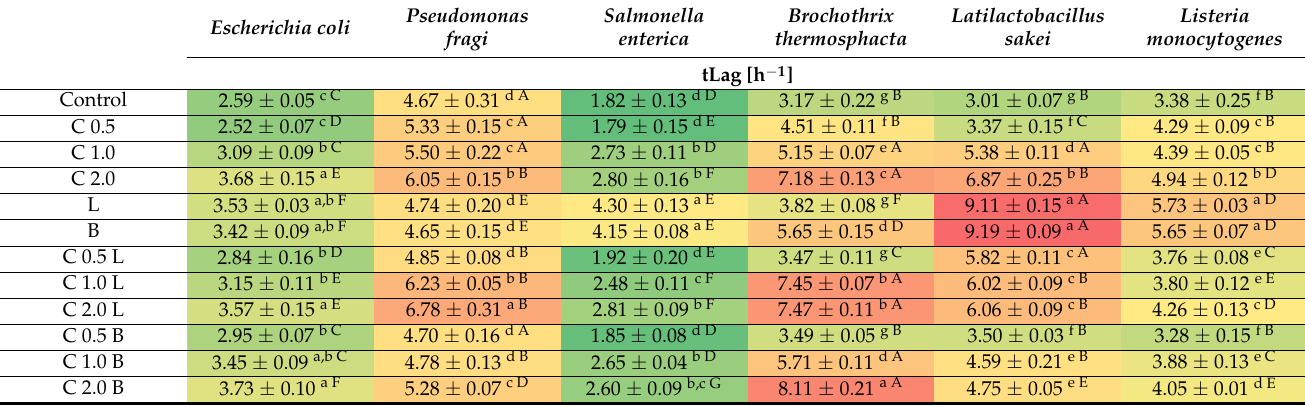
Table 5. Effects of C. incanus extract and dyes on lag time of bacteria (mean ± SD, n =